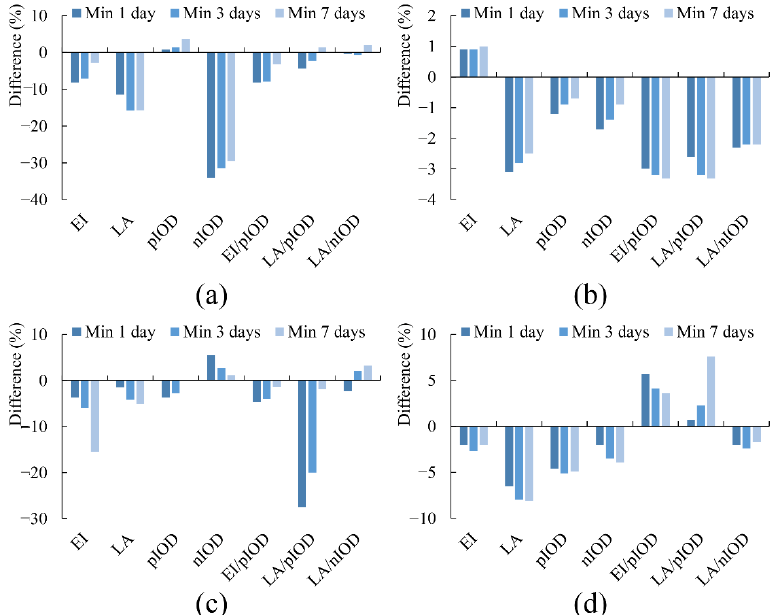
Figure 10. The difference in 1-day/3-day/7-day minimum streamflow relative to neutral years in developing years at ( a ) Zhimenda, ( b ) Shigu, ( c ) Tongzilin, and ( d ) Xiangjiaba.